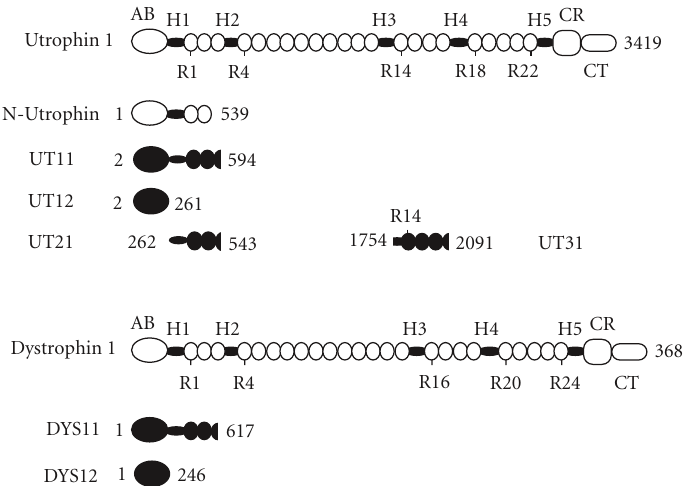
Figure 1: Domain structure of utrophin (rat) and dystrophin (human). Numbers denote amino acid (aa) residues according to rat utrophin. The short N-terminal utrophin isoform (N-utro) extends from aa 1 to 539. The black sections UT11, UT12, UT21, UT31, and DYS12 were used for heterologous expression in bacteria and eukaryotic cells. The recombinant proteins were used for production of antibodies, for in vitro actin-binding studies, and for eukaryotic cell transfection. AB, actin-binding domain; H1–H5, hinge regions; R1–R24, spectrin-like triple helical repeats; CR, cystein-rich domain; CT, C-terminal